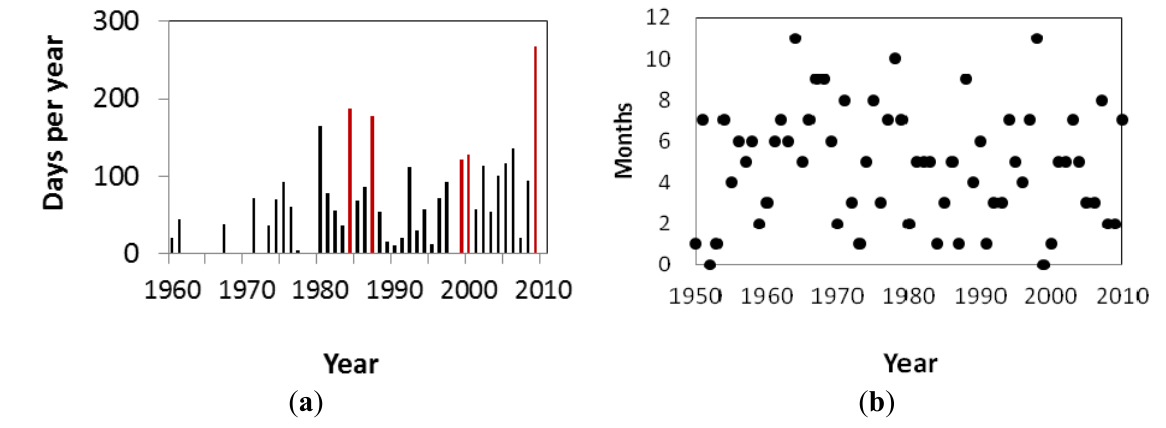
Figure 8. ( a ) Number of days per year with discharge at Archer’s Post below 0.18 MCM per day, the threshold for the river to reach Merti at the head of the Lorian Swamp; red bars indicate drought years; ( b ) Number of months per year when discharge at Archer’s Post exceeded 40 MCM per month, the threshold for the river to reach Habaswein at the end of the Lorian